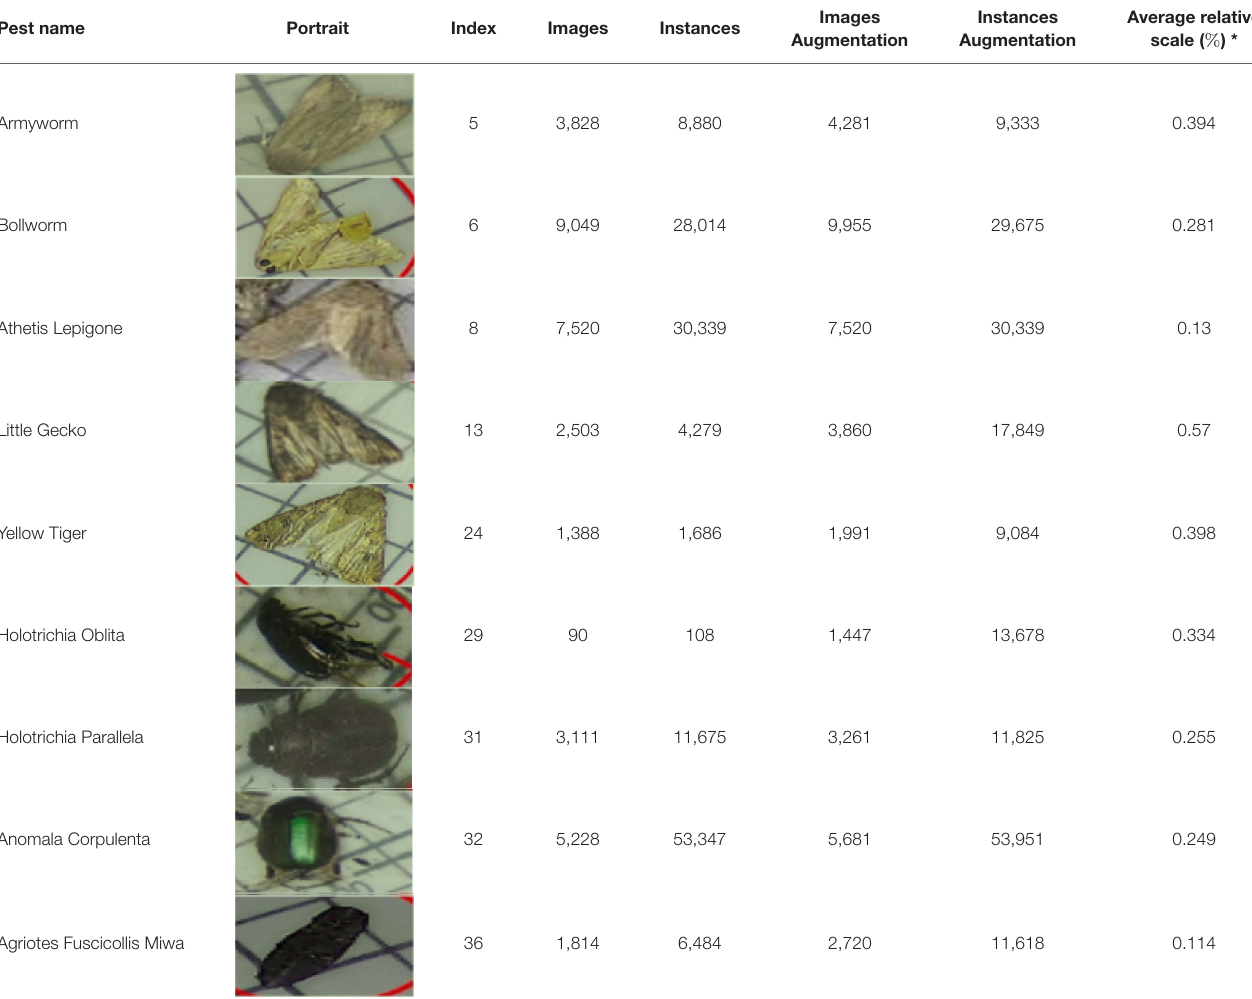
TABLE 1 | Description of the 9 classes of corn pests from the Pest24 dataset. Pest